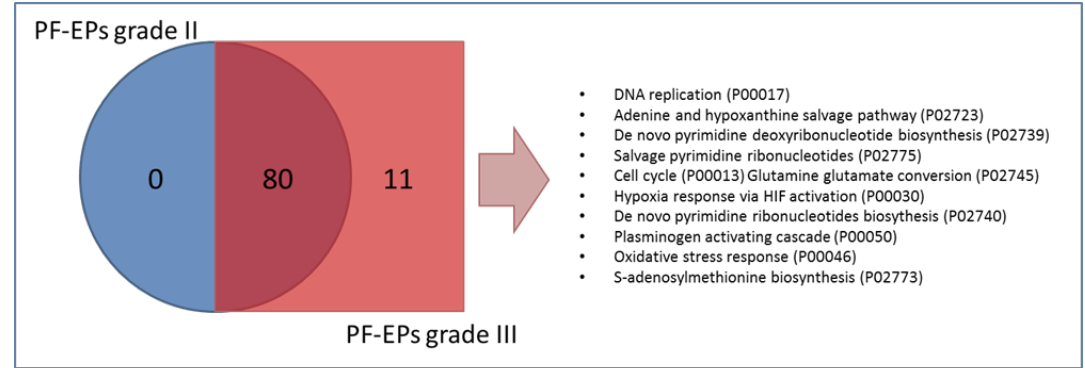
Figure 8. Venn diagram representation of the pathways classified in grade II and grade III PF-EPs. The arrows indicate the description of the 11 pathways exclusively classified in grade III PF-EPs.